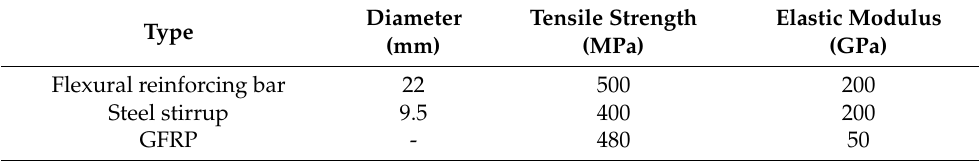
Table 1. Material